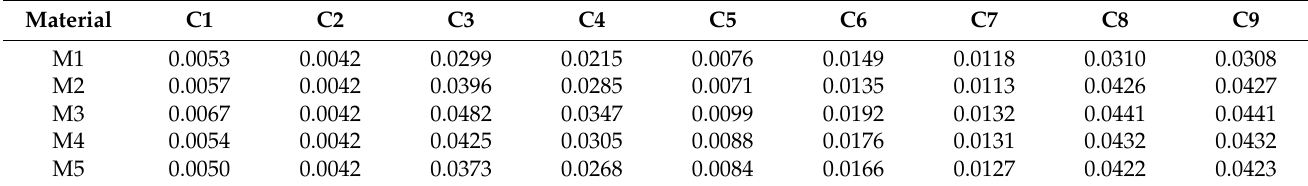
Table A9. COPRAS weighted matrix.